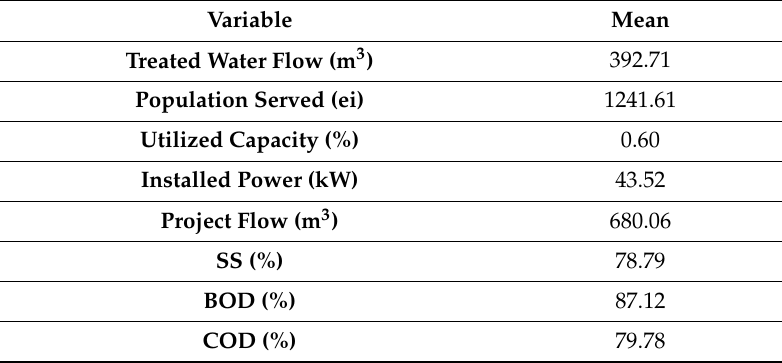
Table 4. Averages of analysis variables for those treatment plants that exceed some limit in terms of disposal